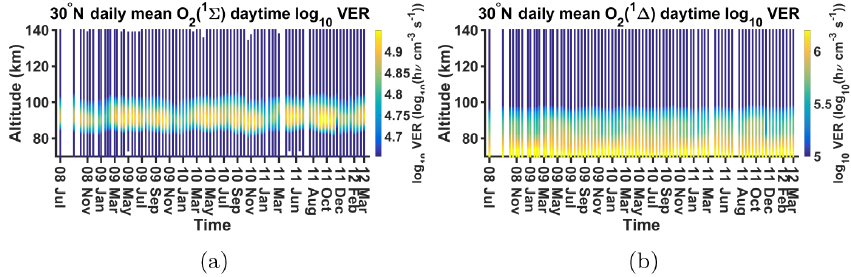
Figure 7. Time series of the daily mean VER. (a) for the daytime O 2 ( 1 (cid:54)) VER; 30 ◦ N; July 2008 to March 2012. (b) as (a) for the daytime O 2 ( 1 (cid:49))